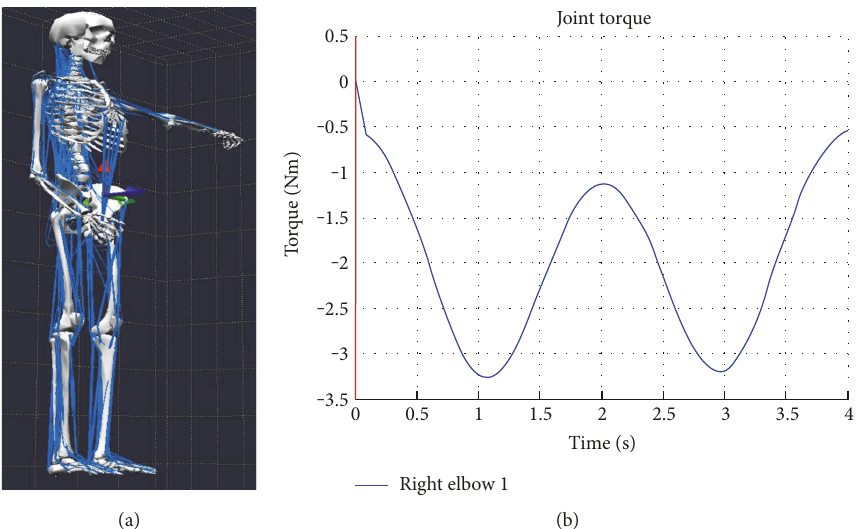
Figure 3: (a) BoB simulator con fi gured in the fl exion-extension of the elbow joint. (b) Simulation results with the necessary torque in the elbow joint.